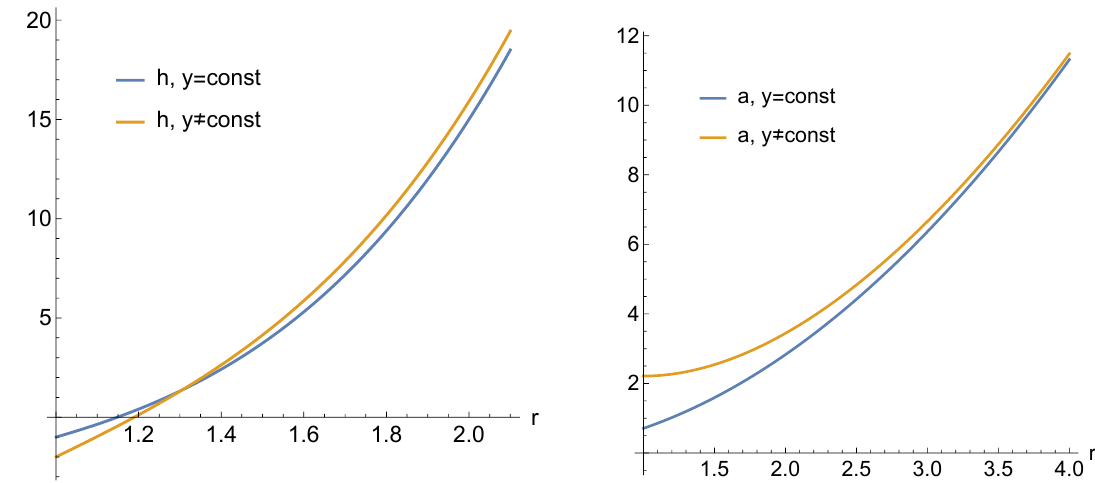
Figure 3 . Black hole solutions for (cid:20) = 0 ; C 1 = 0 and (cid:12) = 1, (cid:3) = 2, M = 1. On the left panel the metric function h is depicted as a function of the radial coordinate for the solution (4.27) and for the solution (4.31), which asymptotes (4.27) for large r . On the left panel the radial component